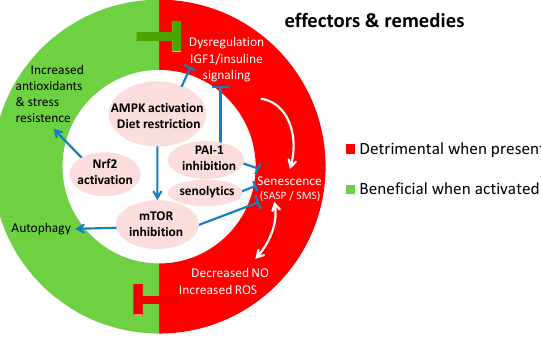
Figure 2. Molecular effectors of genomic instability that contribute to vascular aging, and the potential remedies (center of the chart) against that currently under development. Senescence, imbalanced NO vs. ROS production, inflammation and changes in insulin signaling are detrimental when present while autophagy, apoptosis and stress resistance have a beneficial contribution to vascular aging. IGF-1 putatively has a detrimental effect, although this needs further scrutiny (Ref. [8]). Pointed arrows indicate stimulatory processes, while blunted arrows indicate inhibitory processes.